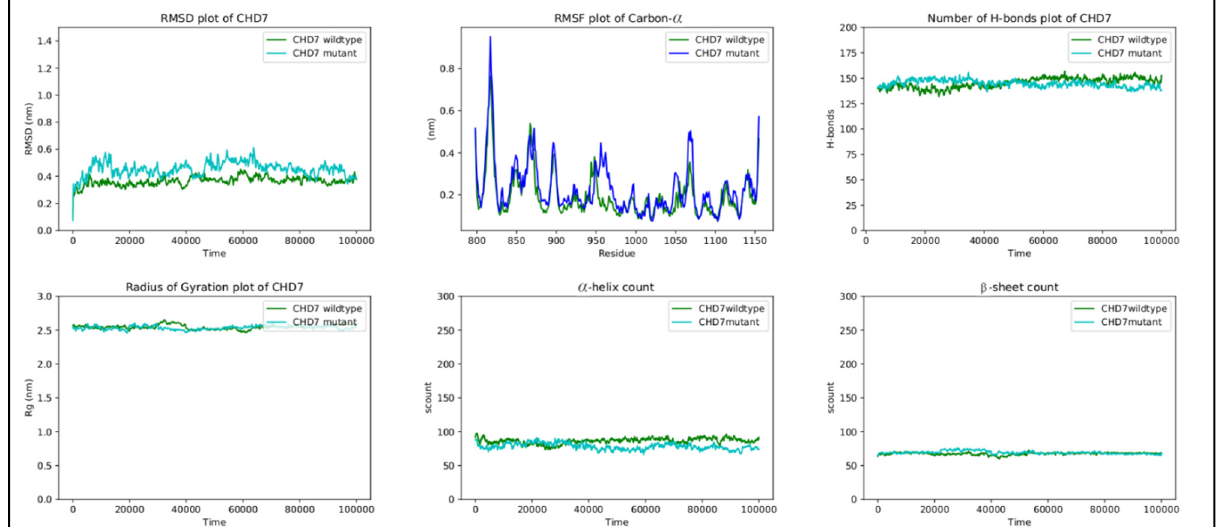
Figure 8. RMSD, RMSF, hydrogen bond count, radius of gyration, and secondary structure count plots of DUSP6 gene. plots of DUSP6